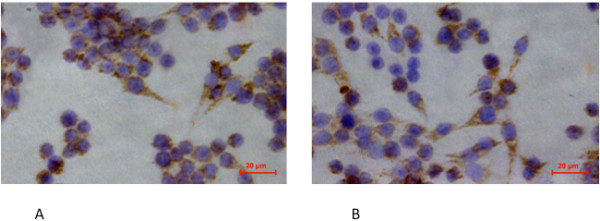
CD14 (A) and CD34 (B) immunohistochemistry of isolated bone marrow macrophages (BMMs).